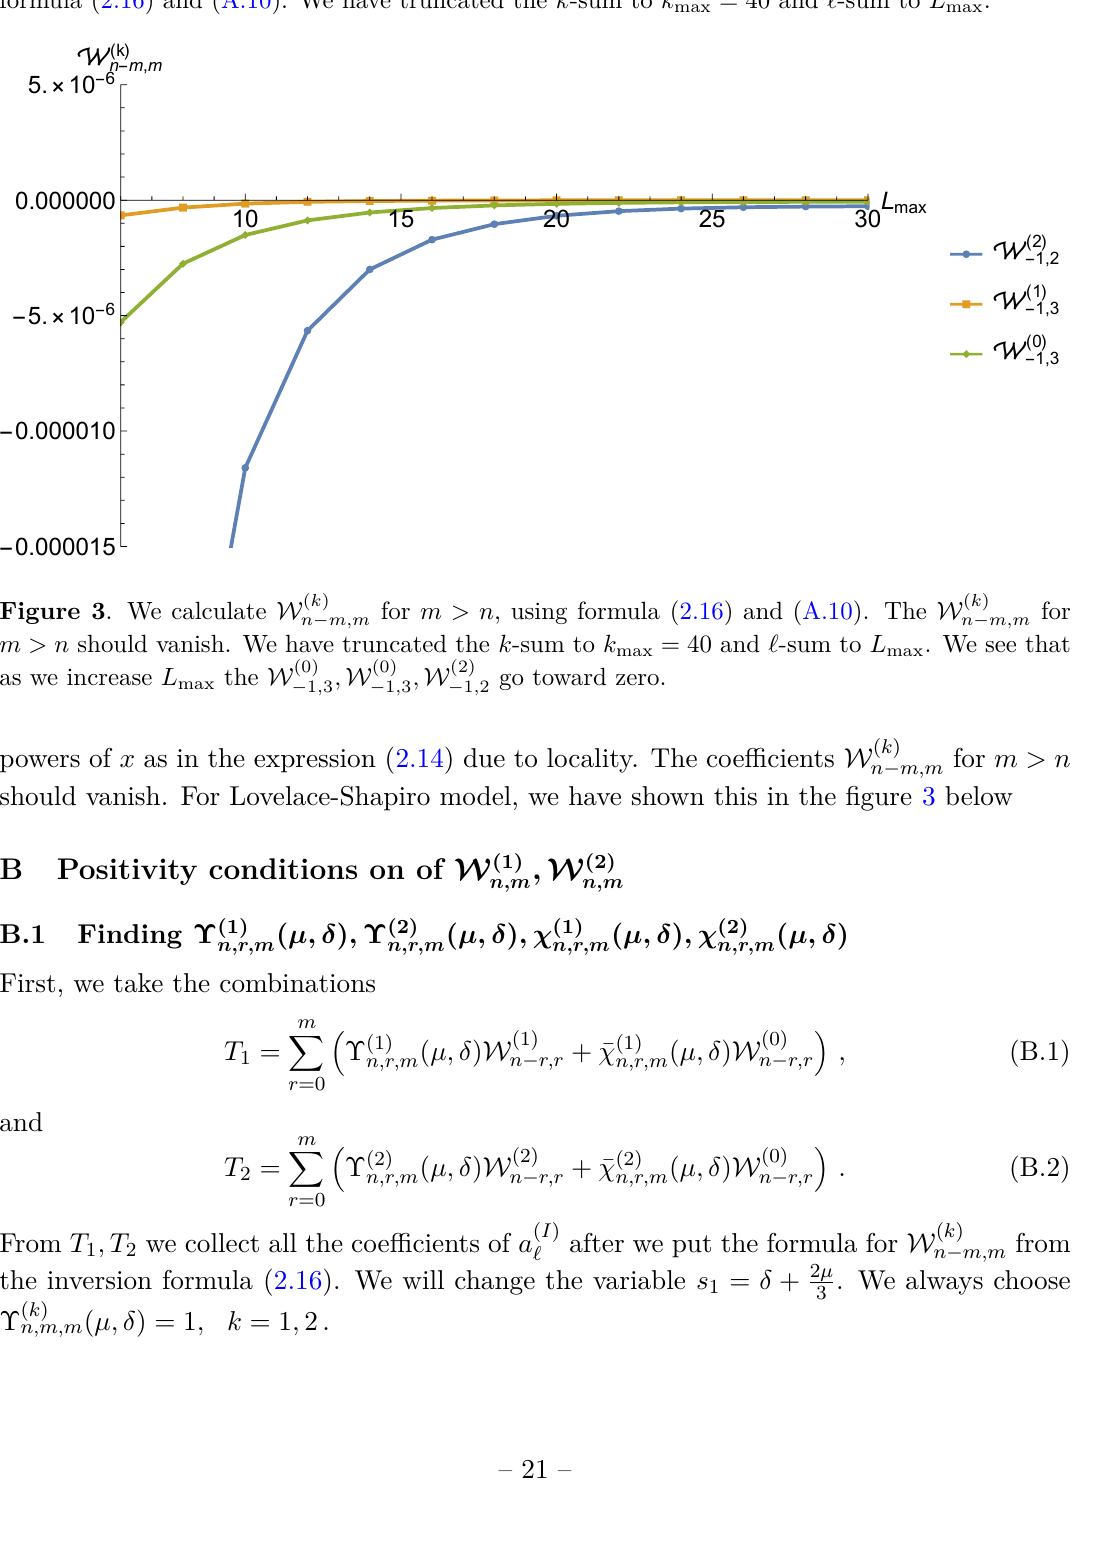
= 40 and ‘ -sum to L . max max